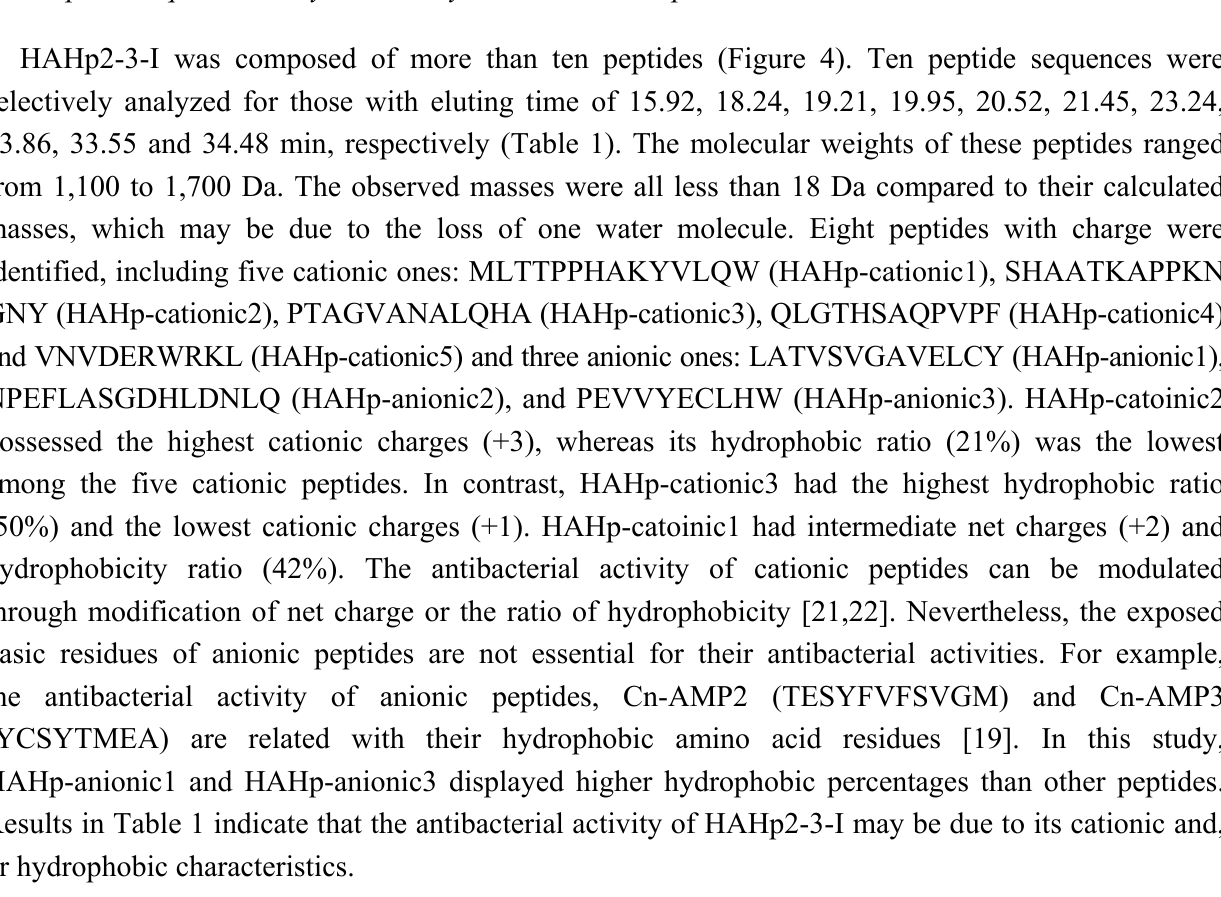
Figure 4. UPLC chromatogram profile (Michrom C